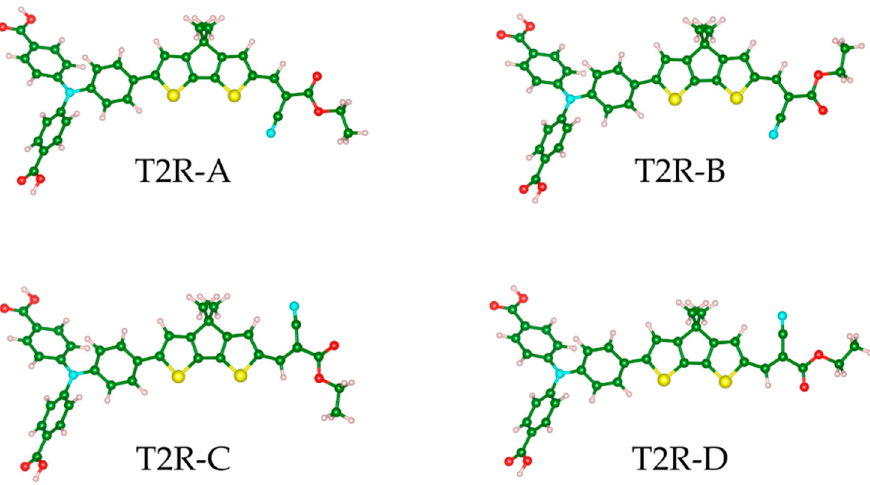
Figure 6. Minimum energy structures of four conformations for the T2R dye obtained by DFT calculations. Table 2. Relative energies ( ∆ E) at the B3LYP level of theory, including zero-point vibrational energies within the harmonic approximation, and vertical transition energies at the CAM-B3LYP level of theory, including the acetonitrile solvent medium via the PCM, with the oscillator strengths given in parenthesis. For the labelling, refer to Figure 6.